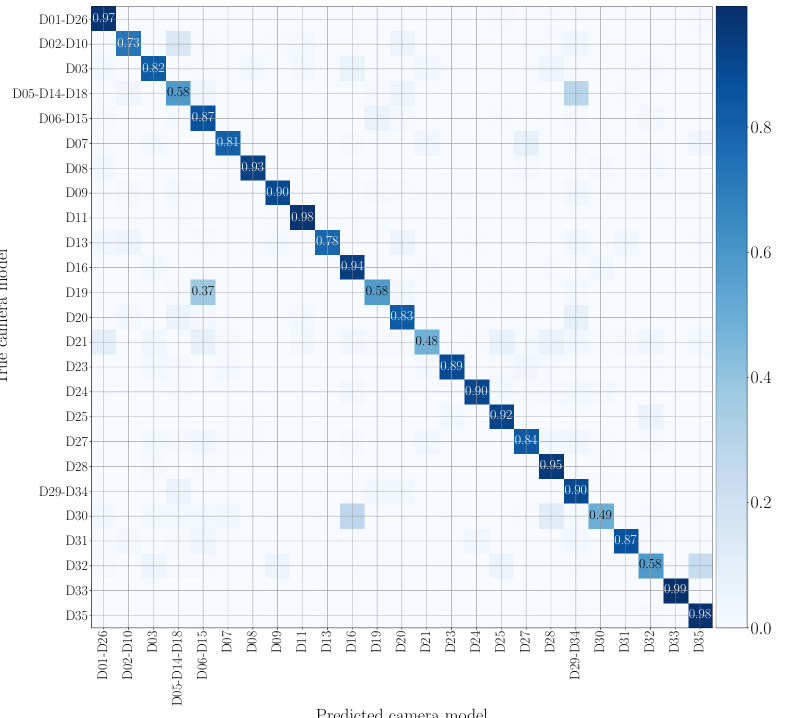
Figure 7. Confusion matrix achieved by mono-modal camera model identification exploiting visual patches only. We report results by training and testing on the native video set, and we only show the numbers which exceed 0.3. Device nomenclature is that of